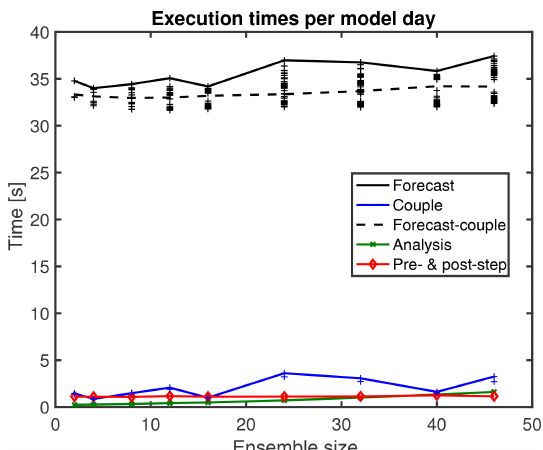
Figure 5. Execution times per model day for varying ensemble sizes for different parts of the assimilation program. The dominating fore- cast time includes the “coupling” time, which results in the time